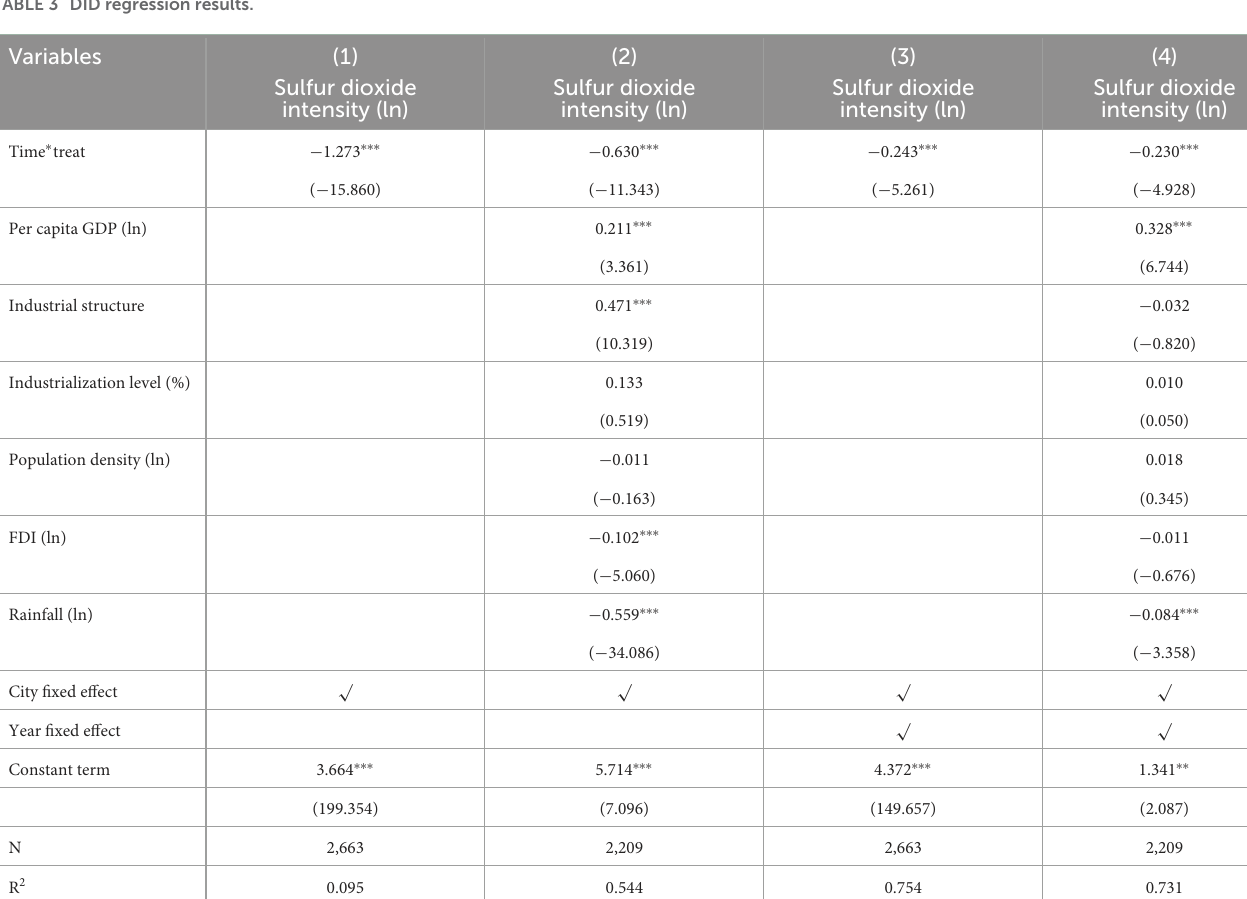
TABLE 3 DID regression